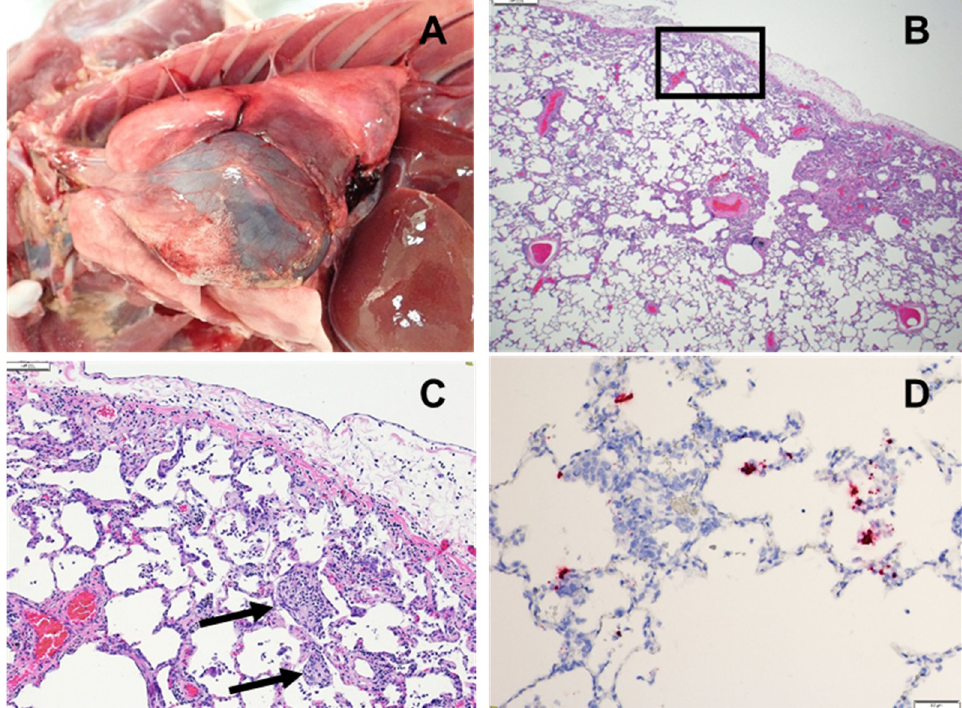
Figure 6. Respiratory pathology in cynomolgus macaques (CM) exposed to SARS-CoV-2 by the aerosol (AE) route. Images shown from animal CM AE 1. ( A ) Thoracic cavity: Multiple fibrinous adhesions between left cranial and caudal lung lobes and the thoracic wall. ( B ) Lung, left caudal lung lobe, peripheral: Multifocal, moderate, interstitial pneumonia with pleural fibrin, 2 × , H&E. ( C ) Lung, higher magnification of boxed area in B: Multifocal moderate lymphohistiocytic interstitial pneumonia with type II pneumocyte hyperplasia, intra-alveolar fibrin deposition (black arrow), septal fibrosis, pleuritis and pleural fibrin, 10 × , H&E. ( D ) Lung: ISH positive in areas of inflammation, 20 × , RNA probe for SARS-CoV-2.